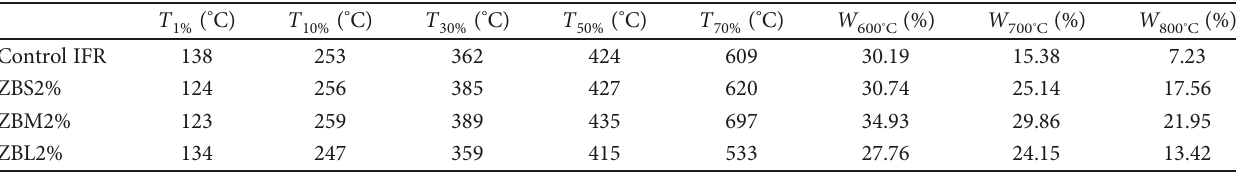
Table 4: TGA data of IFR/ZB coatings (under nitrogen).